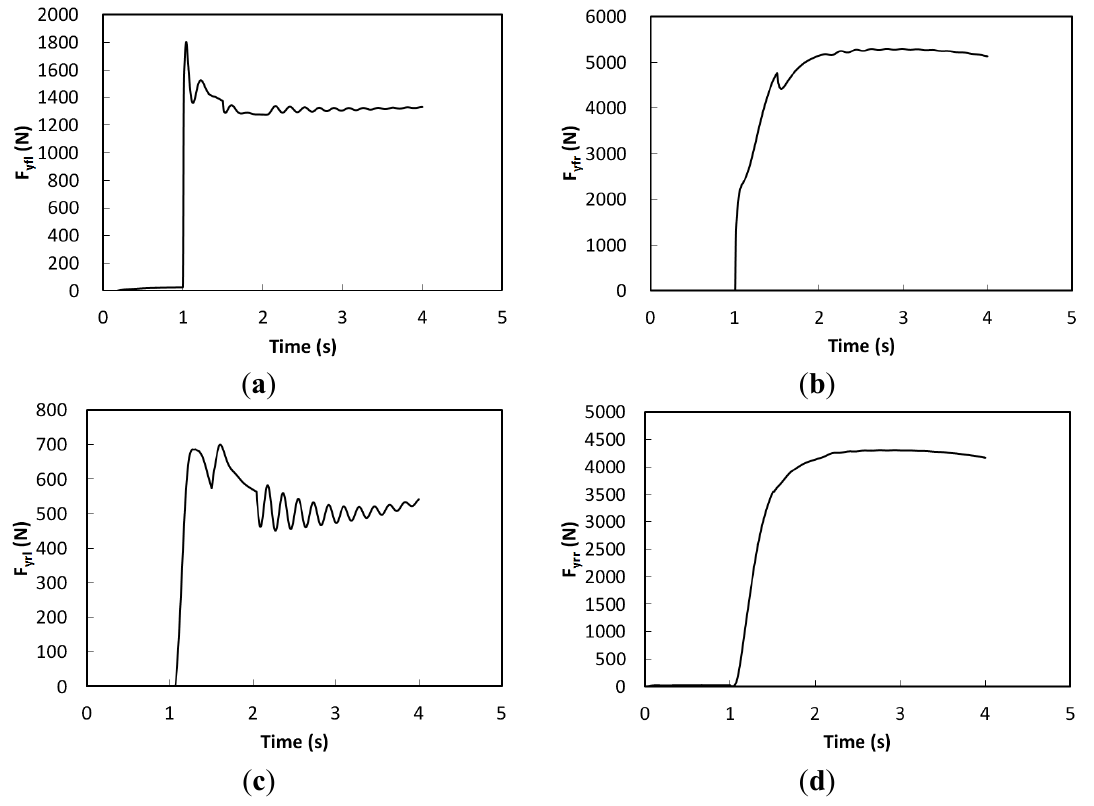
Figure 21. The lateral tire forces with middle level control. ( a ) Front left wheel; ( b ) Front right wheel; ( c ) Rear left wheel; ( d ) Rear right